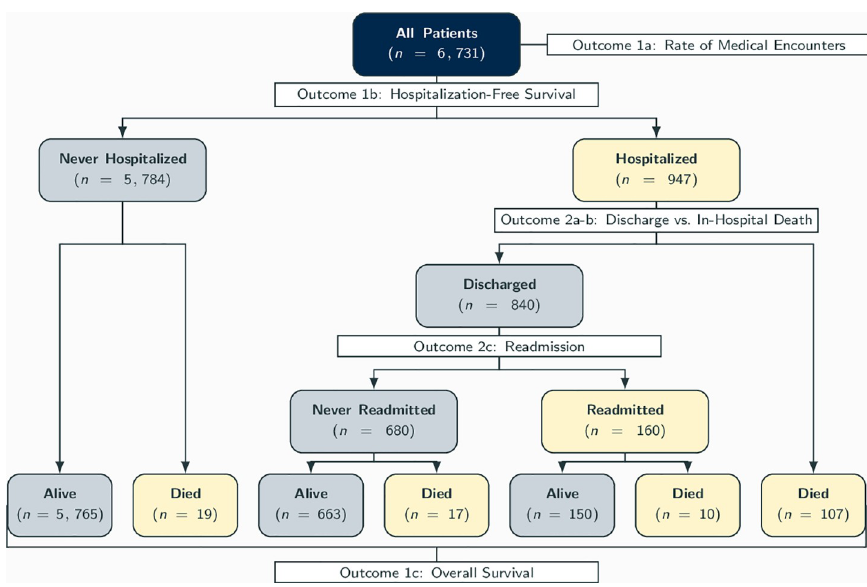
Fig 1. Diagram of disease progression for N = 6, 731 COVID-19 patients, and the relationship between the patient outcomes, patient sub-populations, and models in our analytic workflow.